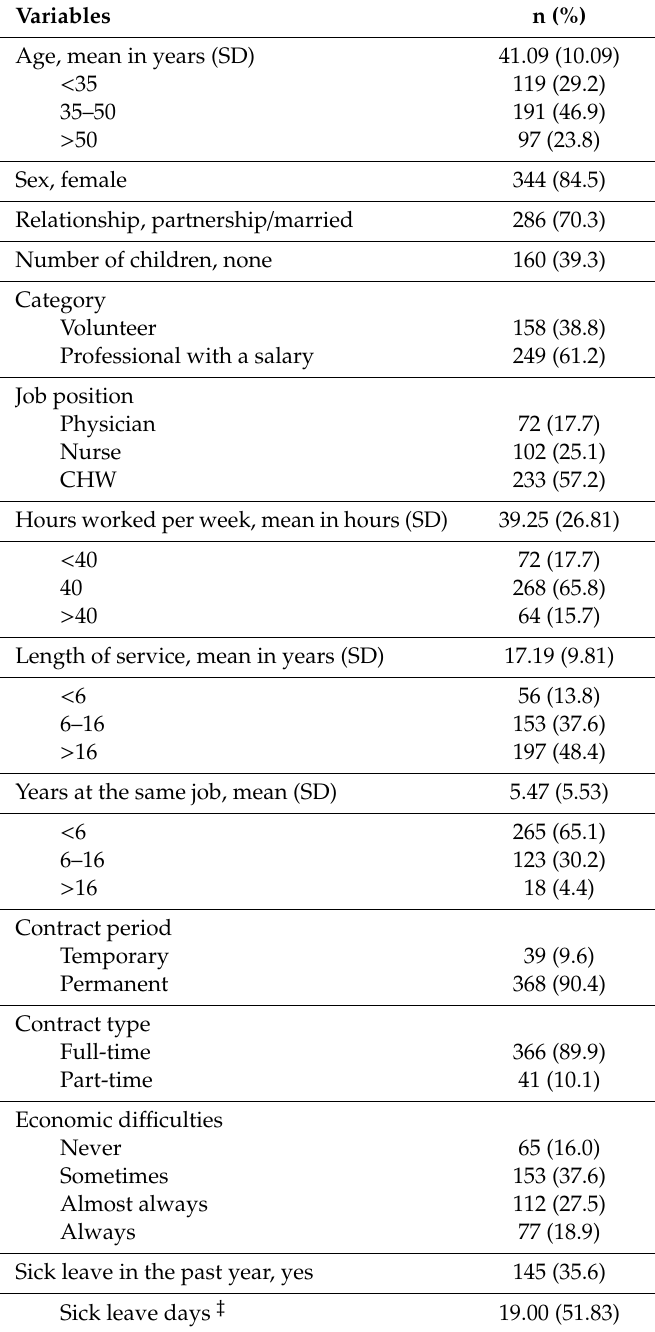
Table 1. Sociodemographic and occupational characteristics of study